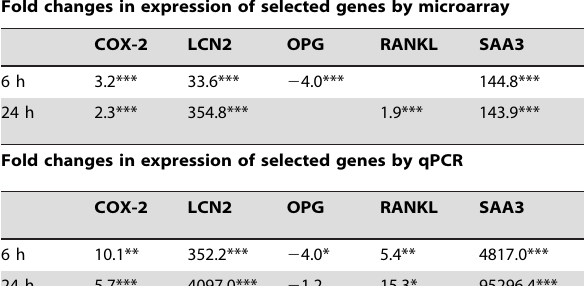
Table 3. Validation of microarray data by qPCR